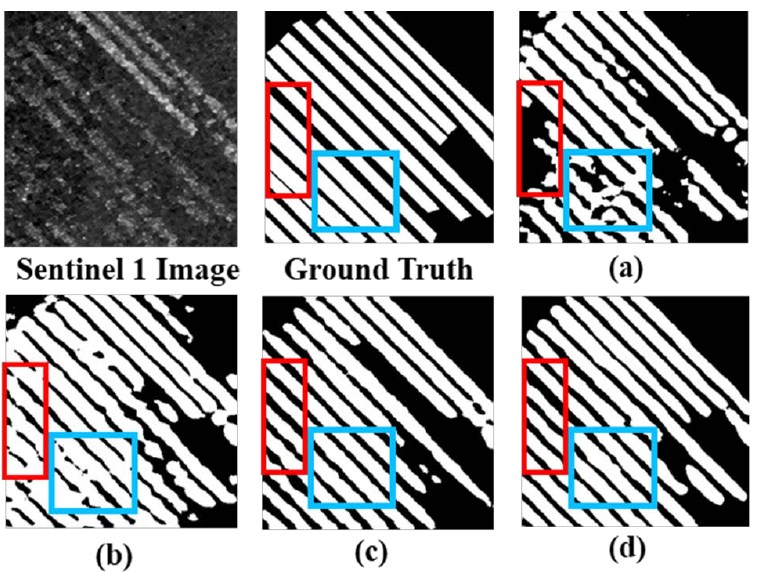
Figure 7. Resulting maps of four DL models. Black pixels represent the ocean background and white pixels represent the extracted FRA areas. Red rectangles are areas where the FRA area is easily missed, and blue rectangles are areas where the FRA extraction result is prone to adhesions. ( a ) The results obtained by U-Net; ( b ) the results obtained by ResNet34 + U-Net; ( c ) the results obtained by ResNet34 + residual decoder + U-Net; ( d ) the results obtained by proposed D-ResUnet (Pre-trained ResNet34 + residual decoder + U-Net).